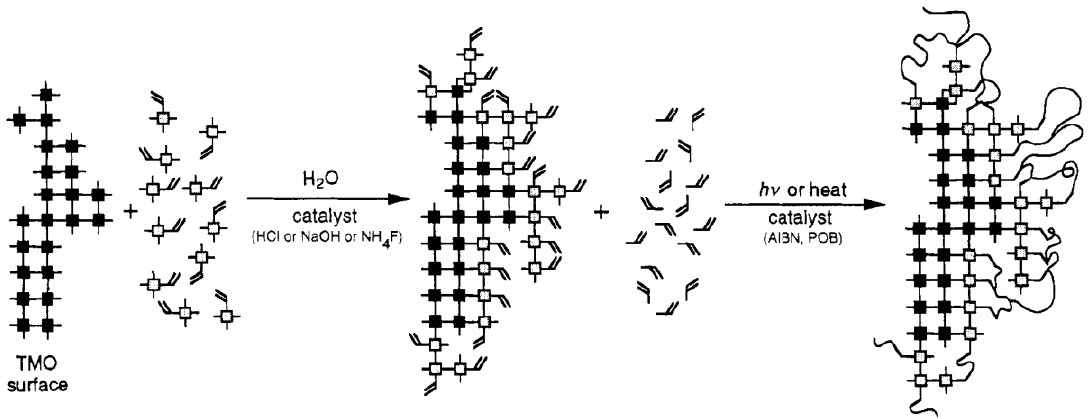
Figure 10. Formation procedures of inorganic–organic composites from organically modified silanes and transition-metal oxides. Reproduced from [82].